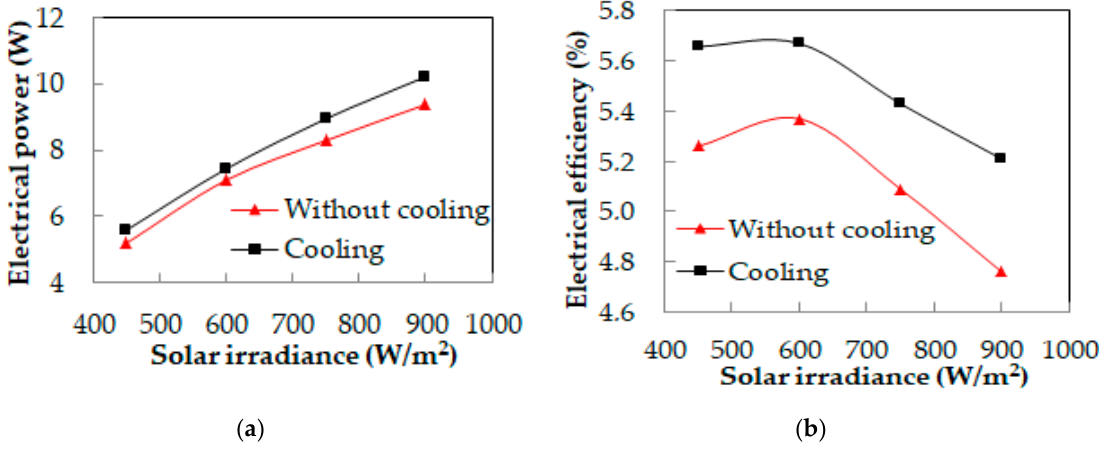
Figure 7. The PV roof tile electrical characteristics: ( a ) the electrical power variation with the solar irradiance; and ( b ) the electrical efficiency variation with the solar irradiance.